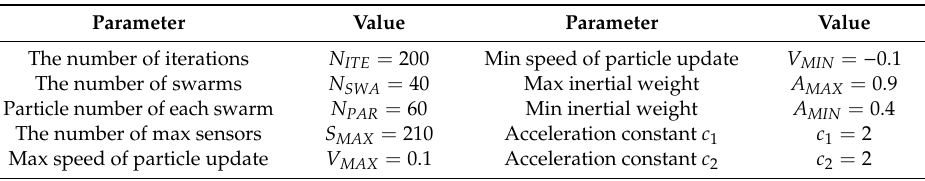
Table 7. Parameters of Algorithm 1 in Figure 16.